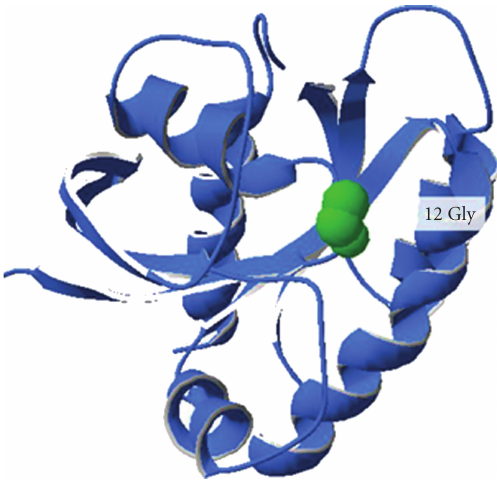
Figure 4: Position of codon 12 in KRAS molecule. Wild type aminoacid at codon 12 is shown in